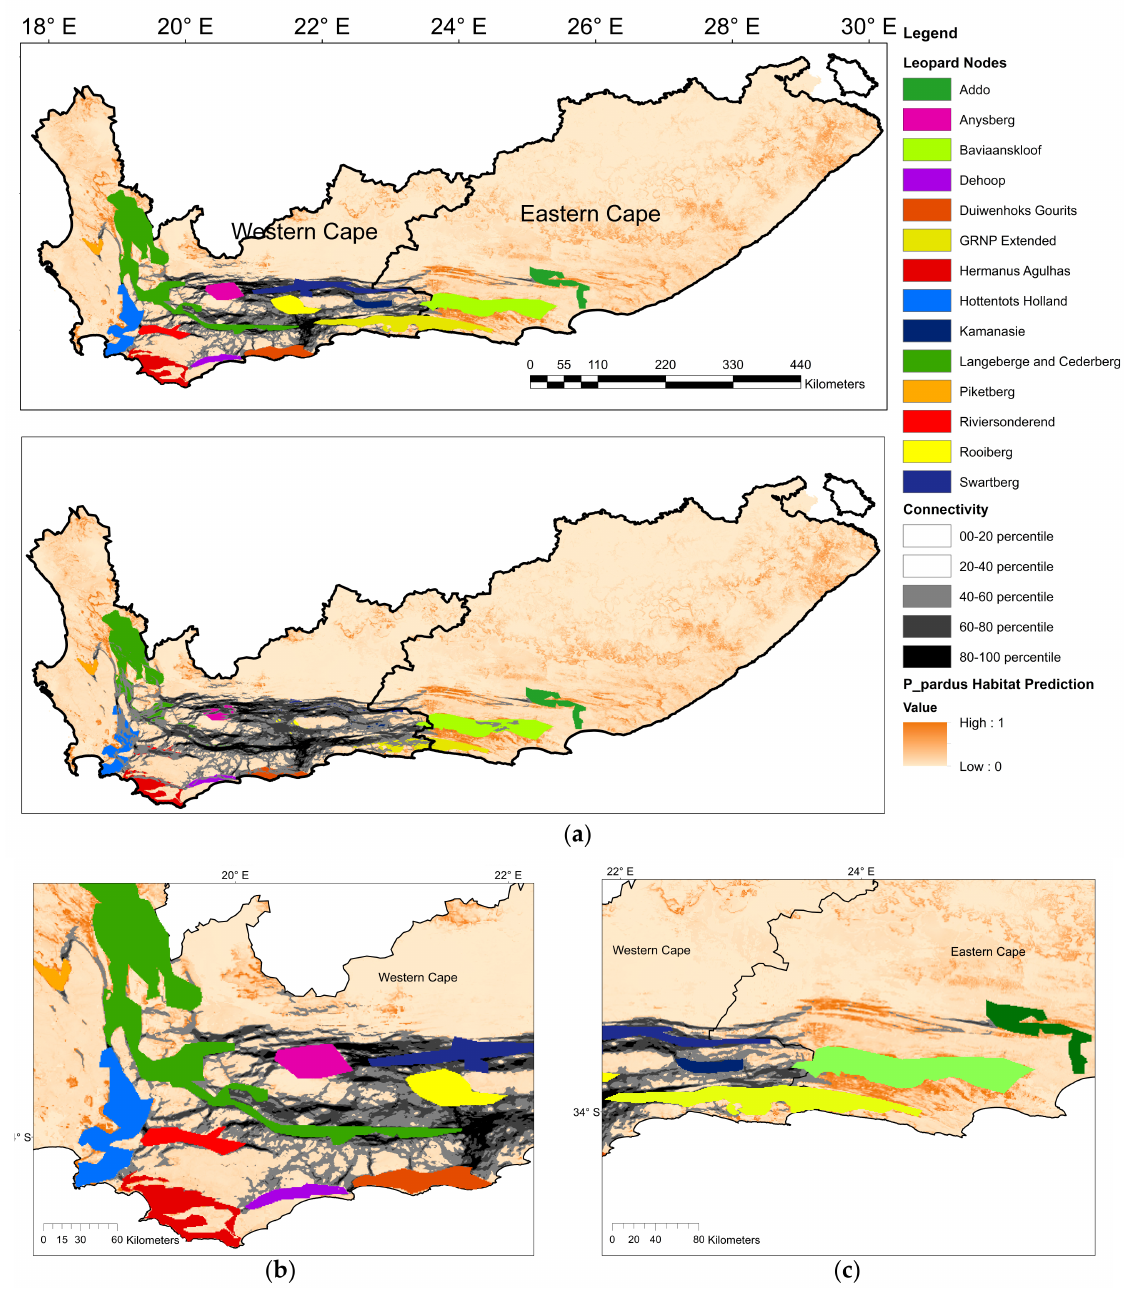
Figure 5. ( a ) The figure above indicates 14 nodes known to host leopard populations, connected by connectivity categories. Connectivity categories were based on natural breaks in the data (Jenks method). We display categories indicating potential permeability (40–60 percentile), moder- ate permeability (60–80 percentile and high permeability (80–100 percentile) overlaying predicted leopard habitat for reference. The figure below depicts connectivity categories overlaying nodes. ( b , c ) provides a finer scale focus on the Western Cape and Eastern Cape,